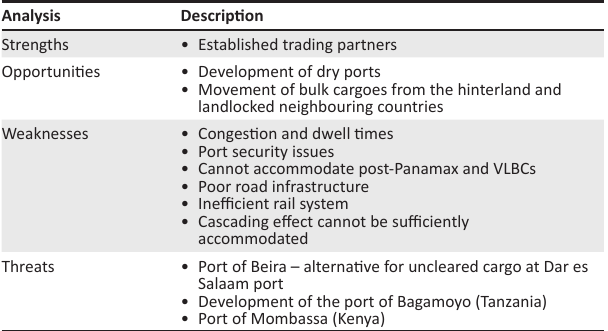
TABLE 3: Strengths, weaknesses, opportunities and threats analysis of Dar es Salaam port.